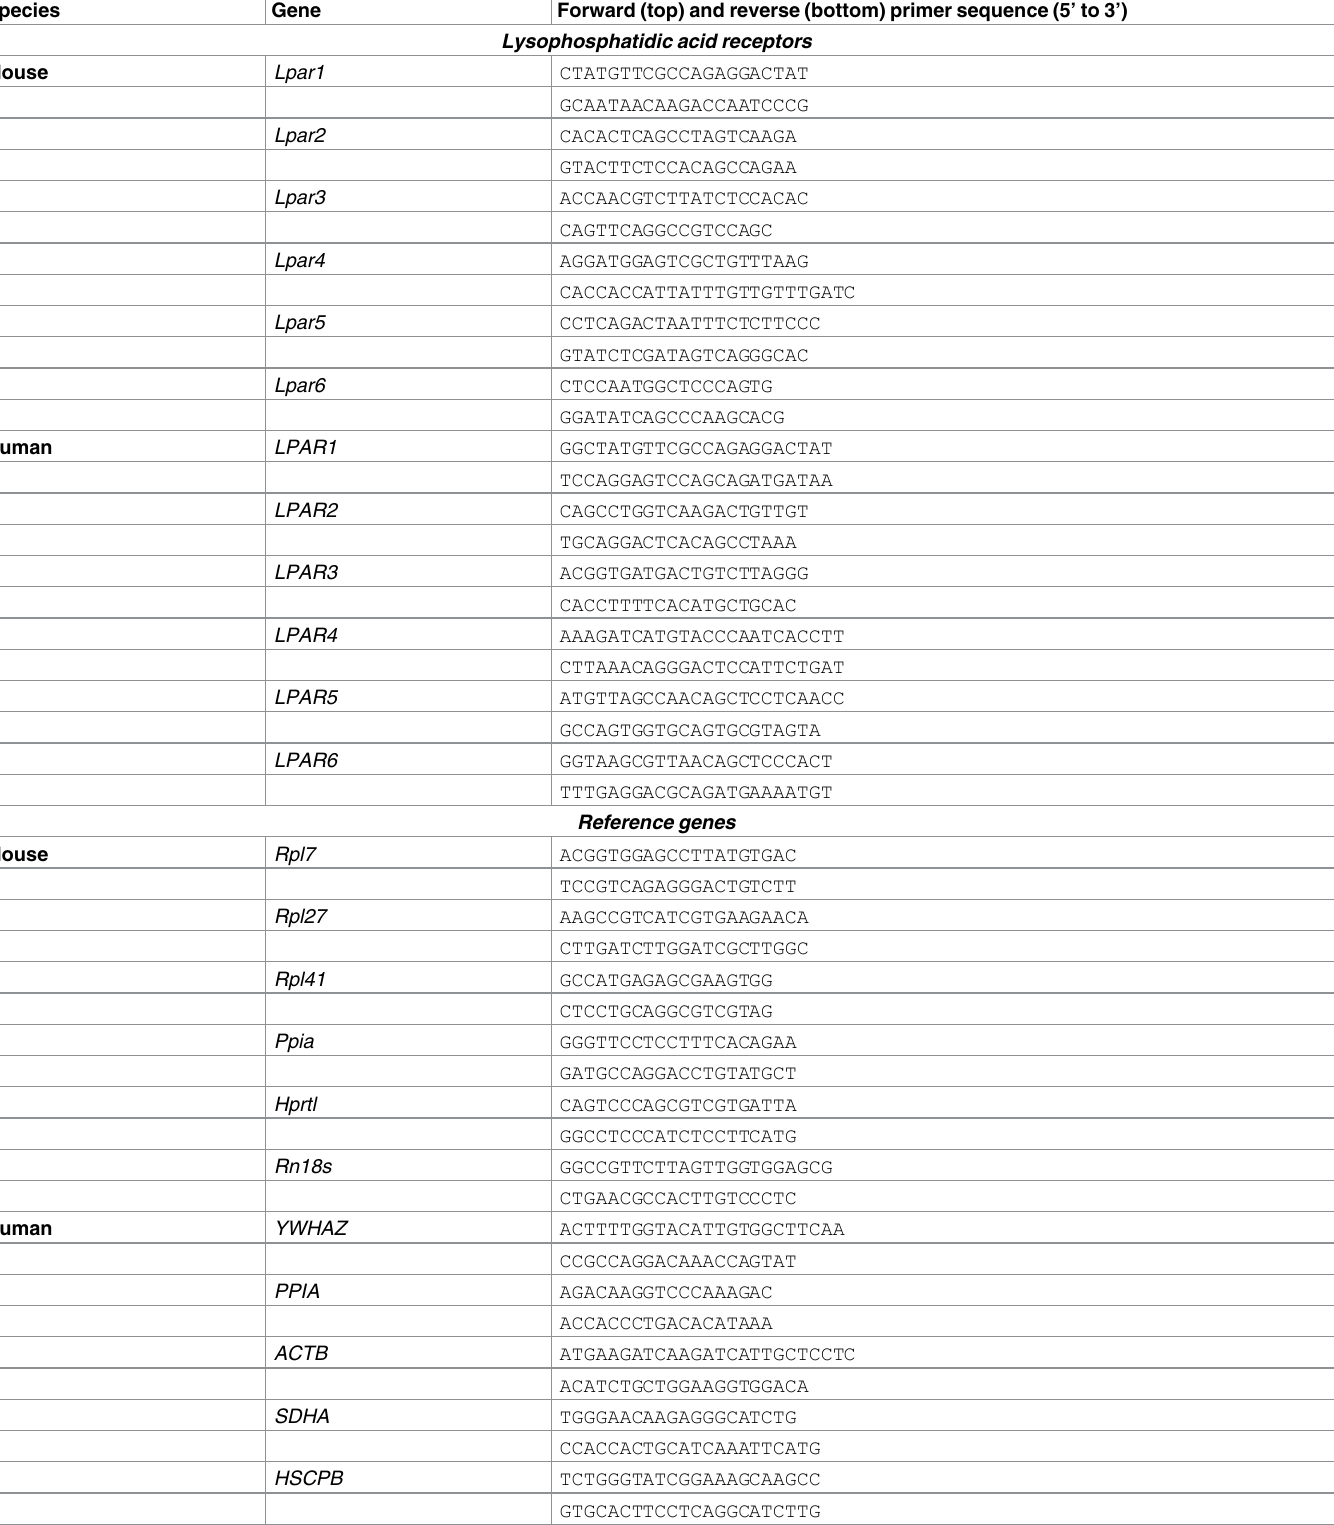
Table 2. Sequence information for primers employed in qPCR